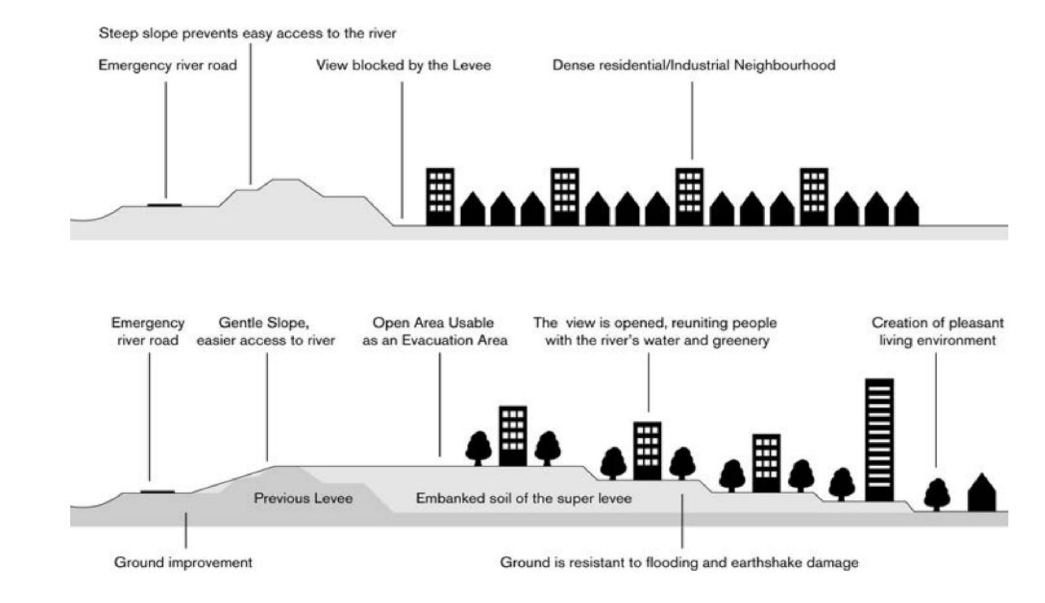
Figure 15. Comparison of a traditional ( top ) and super embankment ( bottom ), also known as a “super levee” (Arakawa-Karyu River Office and MLIT)